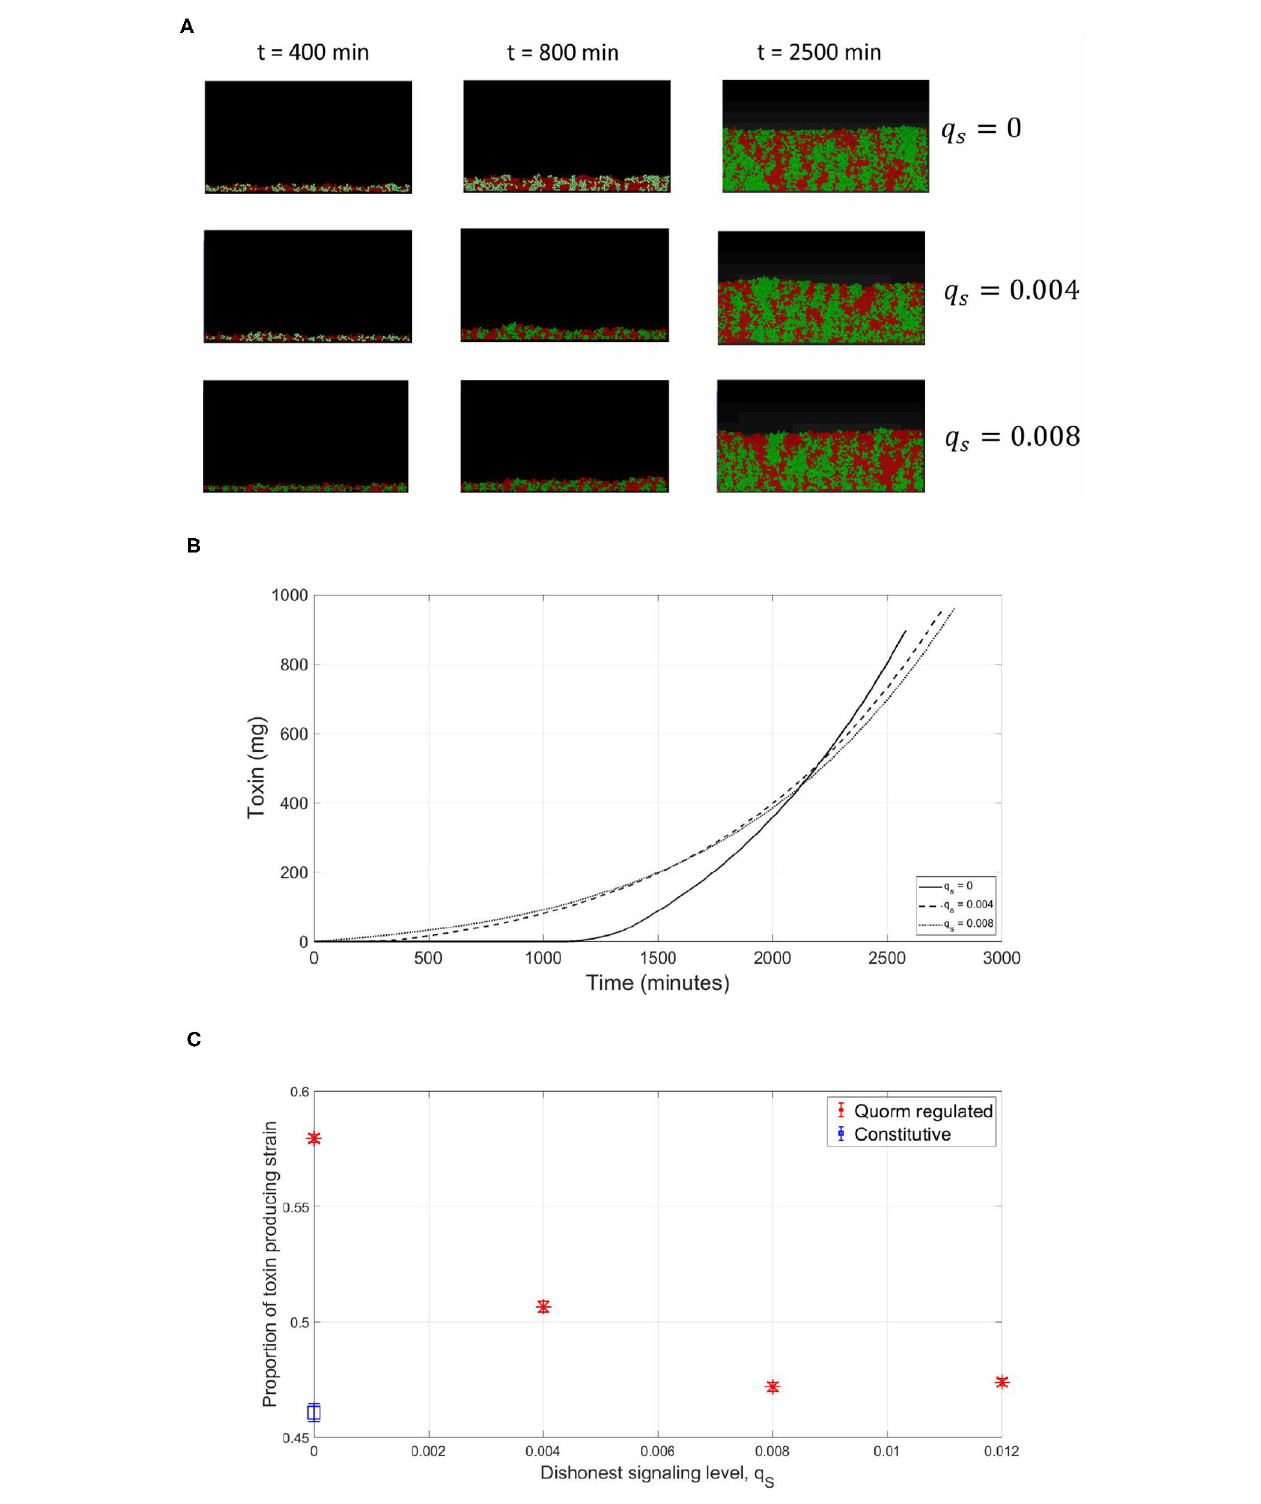
FIGURE 8 | Spatial competition, cheap signaling (lower than LERS). Similar to the observations in the well-mixed case, the sensitive strain gain advantage by engaging in dishonest signaling when competing with a focal QS toxin producing strain. (A) An individual-based model for a competition between a focal QS toxin producer (green) and a sensitive strain (red), under different dishonest signaling levels from the sensitive strain. (B) The total quantity of toxin produced as a function of time in the simulations. (C) The proportion of the focal toxin producing strain at the end of the experiments under different levels of dishonest signaling.